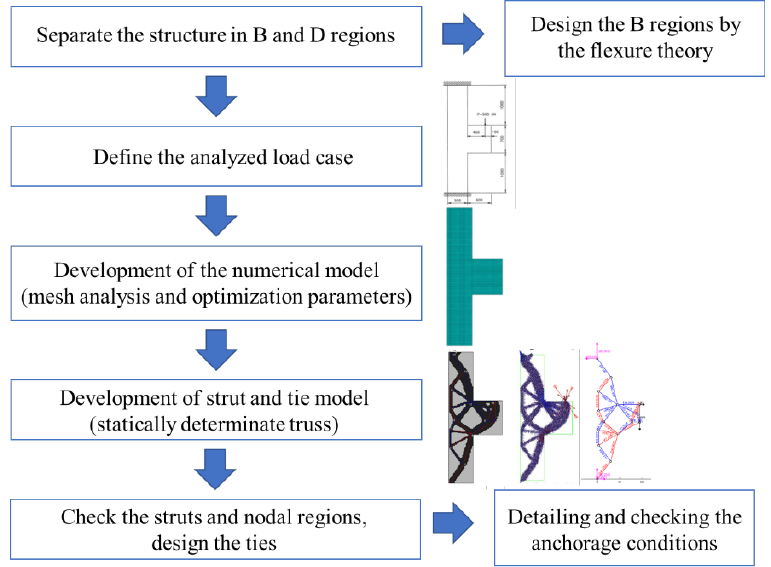
Figure 5. Design sequence with optimization